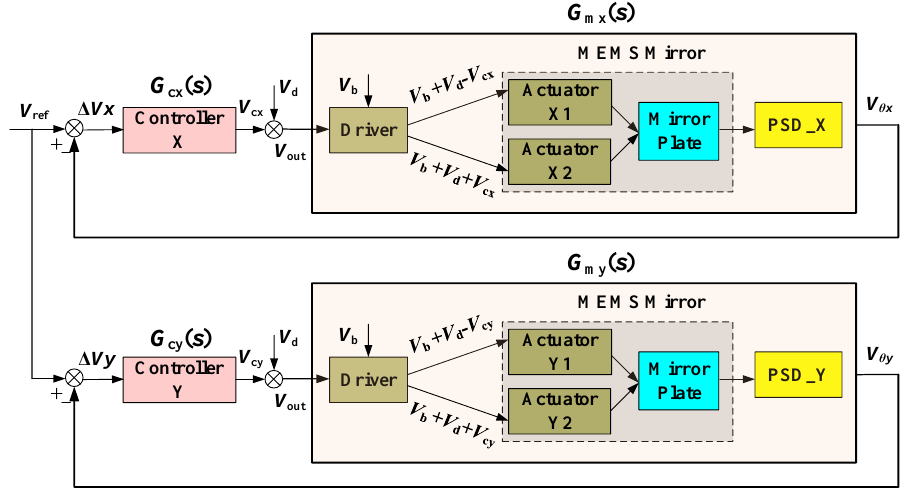
Figure 6. Block diagram of the closed-loop micromirror tilt control system. G cx ( s ) and G cy ( s ): the feedback controllers in x and y directions; G mx ( s ) and G my ( s ): the micromirror systems under control in x and y directions, including the drivers, actuators, micromirror plate, and position sensitive detector (PSD).